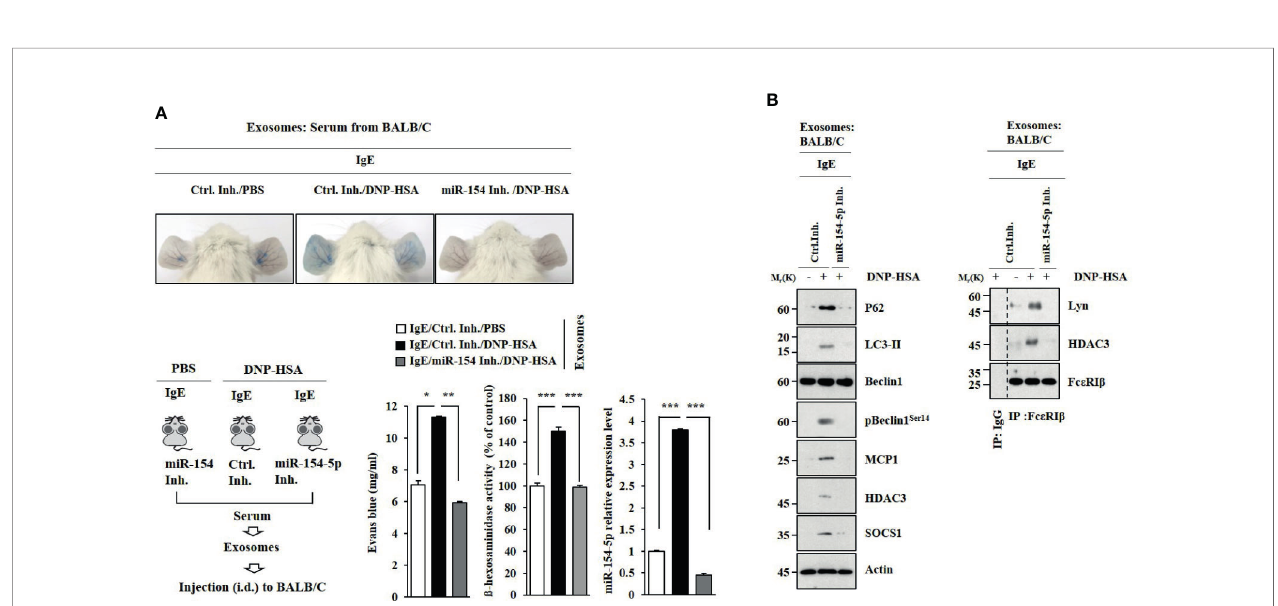
FIGURE 8 | Exosomes induce features of passive cutaneous anaphylaxis. (A) PSA was performed as described. Exosomes were isolated from serum of BALB/ C mouse of each experimental group. BALB/C mice were given an intradermal injection of exosomes (200 m g/mouse). Twenty-four hours after the injection, vascular permeability was determined. b -hexosaminidase activity assays and qRT-PCR analysis were performed. * p <0.05; ** p <0.01; *** p <0.001. Average values of three independent experiments are shown. (B) Immunoblot and immunoprecipitation were performed. Representative blots of three independent experiments are